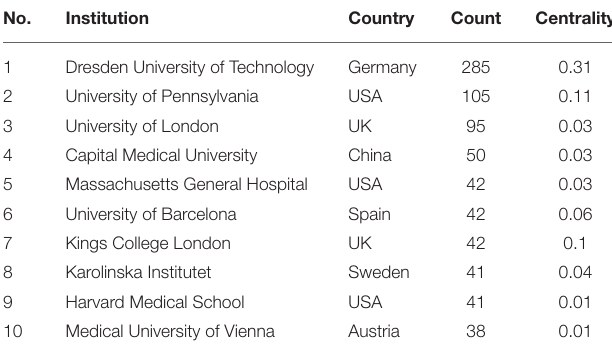
TABLE 2 | Top 10 institutions with the most publications in the field of olfactory dysfunction from 2002 to 2021. No.